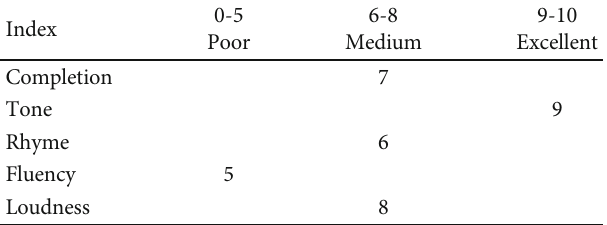
Figure 6: Memory consumption comparison results. Table 1: Judgment standard of pronunciation